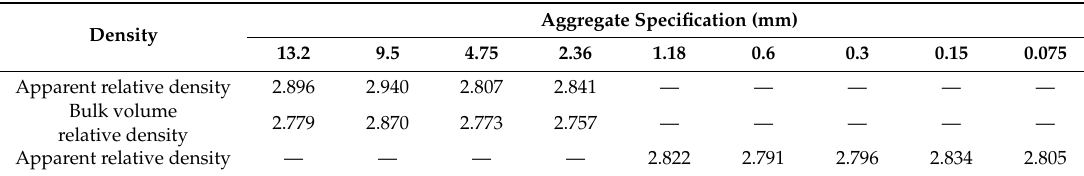
Table 3. Coarse aggregate and finer aggregate density.